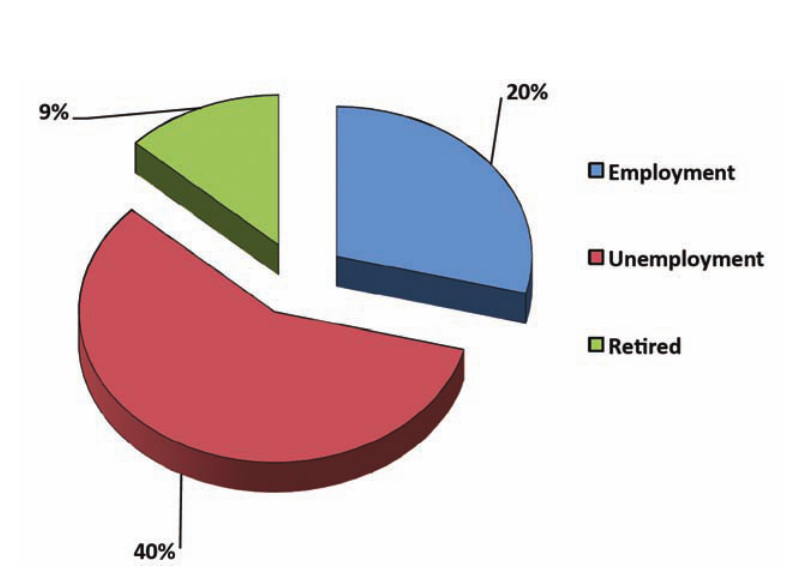
Figure 2. Employment and unemployment of the patients interviewed